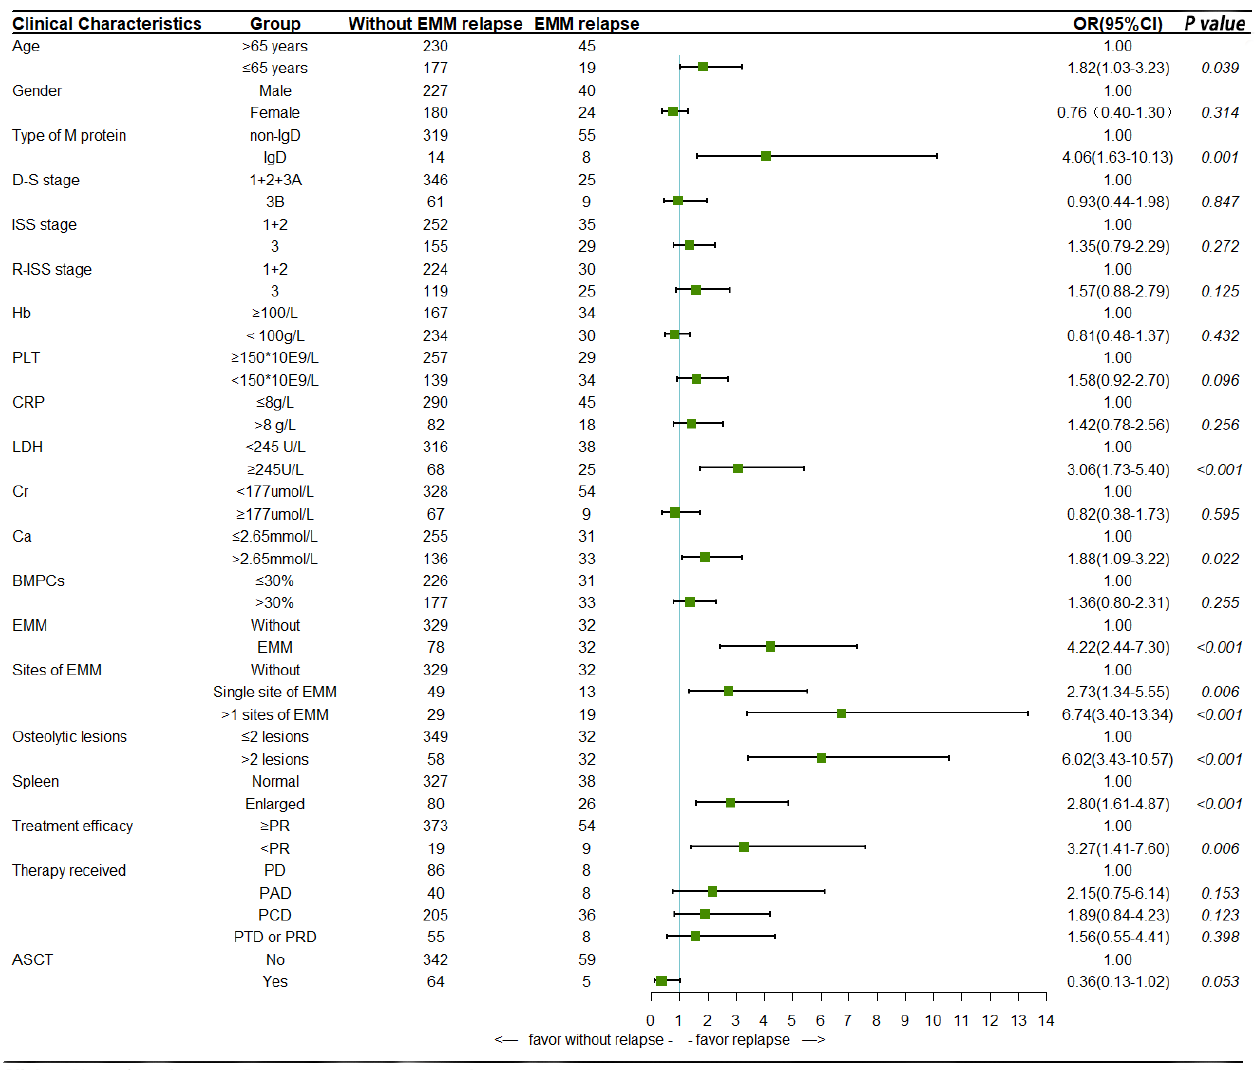
Figure 3. Univariate analysis of risk factors for extramedullary relapse in newly diagnosed MM patients.